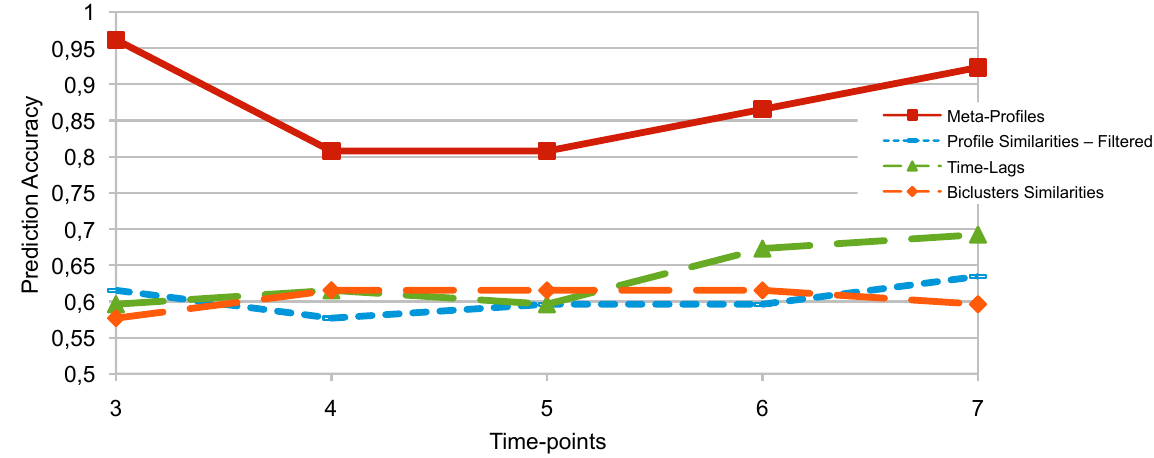
Figure 5: Prediction accuracies for the analysis using 3 to 7